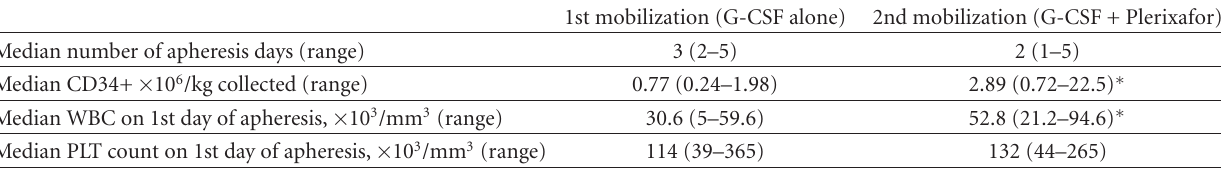
Table 5: Comparison of laboratory and clinical data of truly poor mobilizers (defined as not achieving ≥ 2 × 10 6 CD34+ cells/kg with first mobilization) during their 1st and 2nd mobilizations.